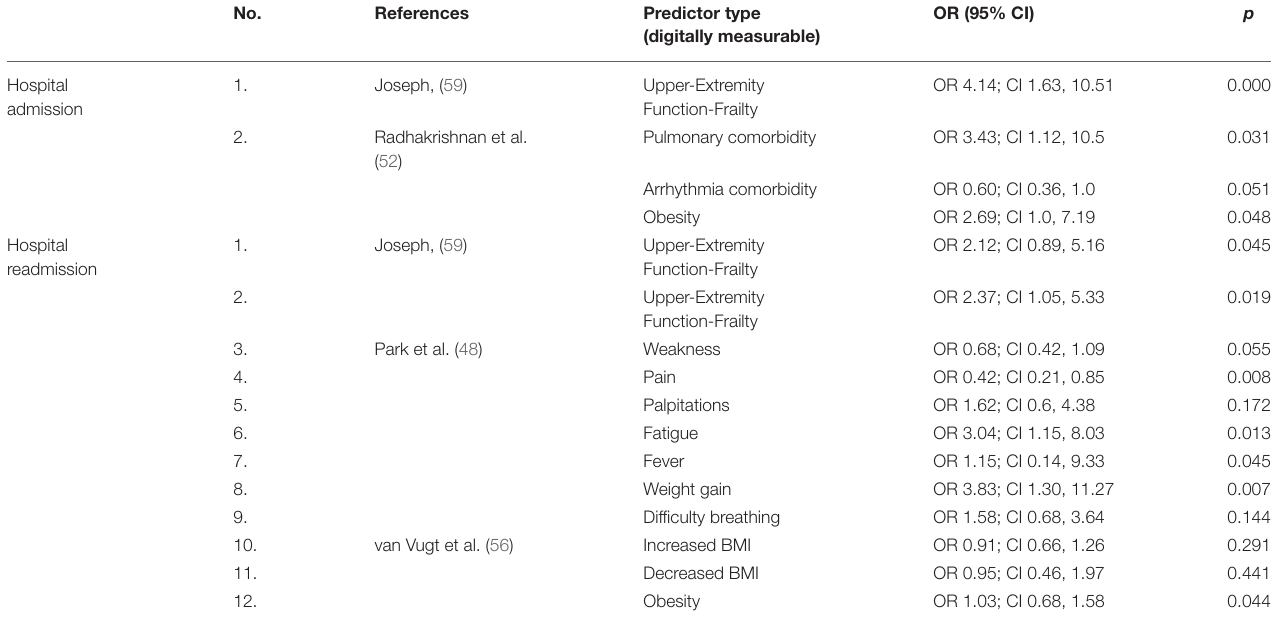
since the number of studies included in these analyses was small (23).